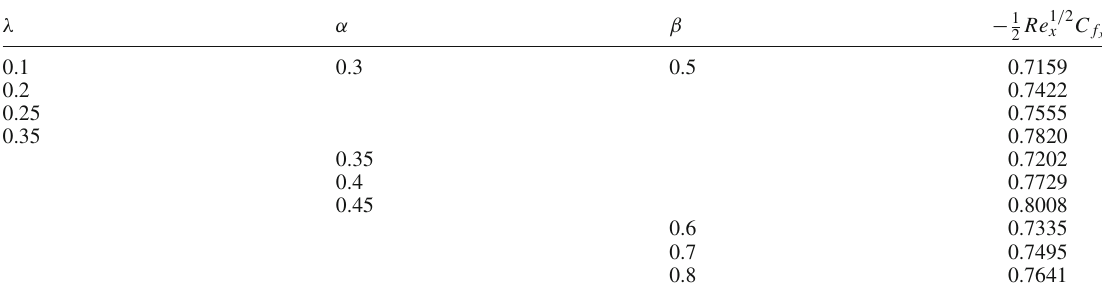
/ 2 Re 1 x C f x for different parameters 2